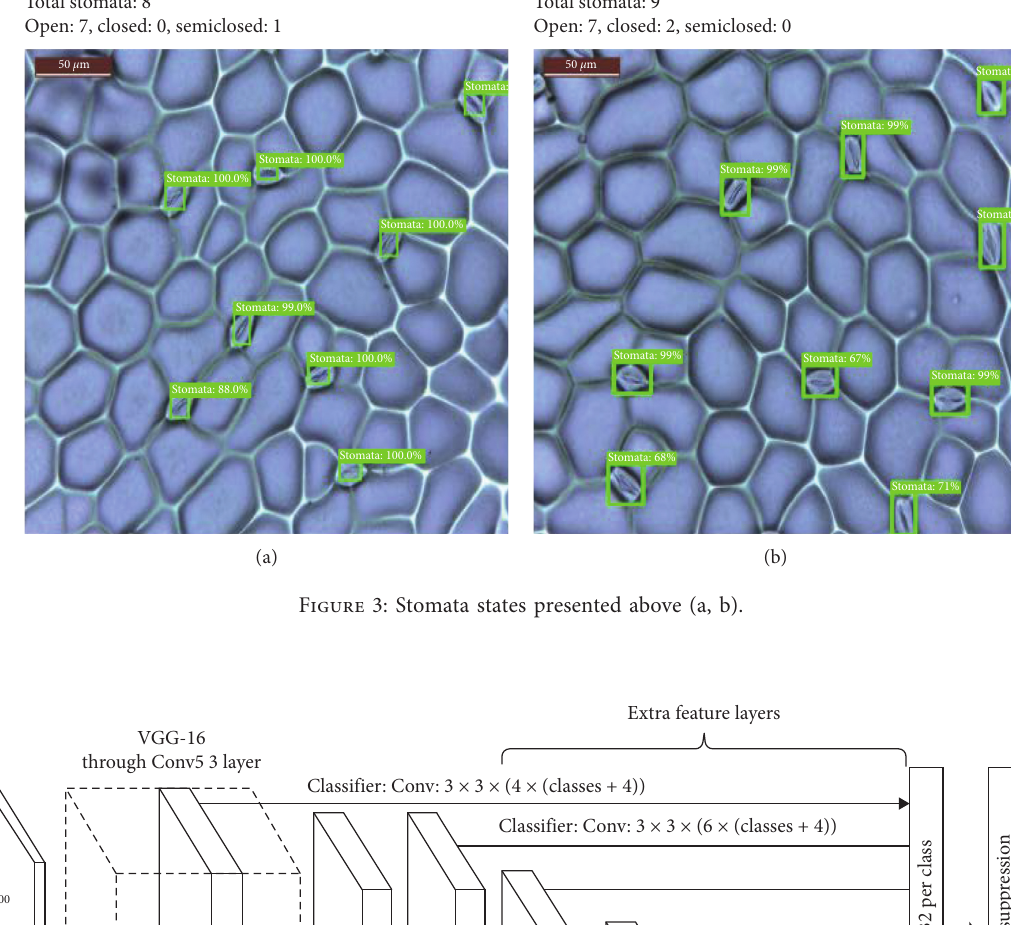
Figure 3: Stomata states presented above (a, b).